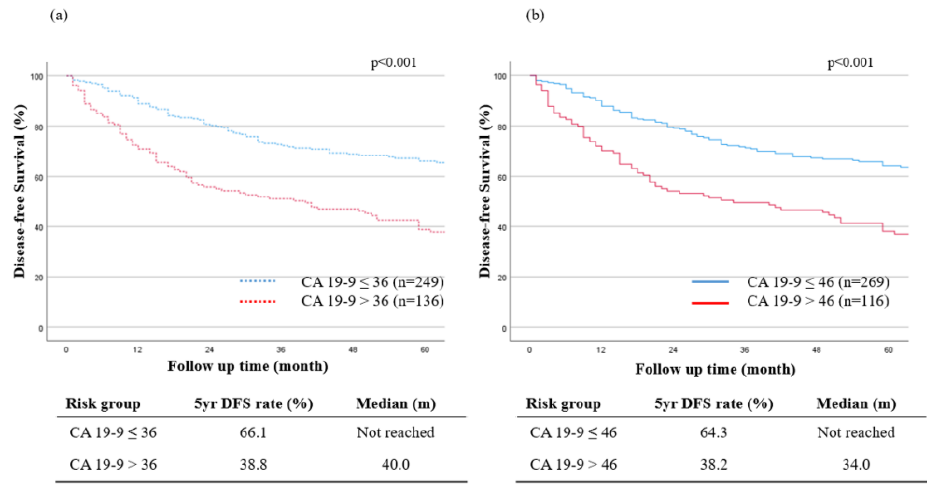
Figure 4. Disease-free survival according to ( a ) CA 19-9 level 36 U/mL and ( b ) level 46 U/mL.